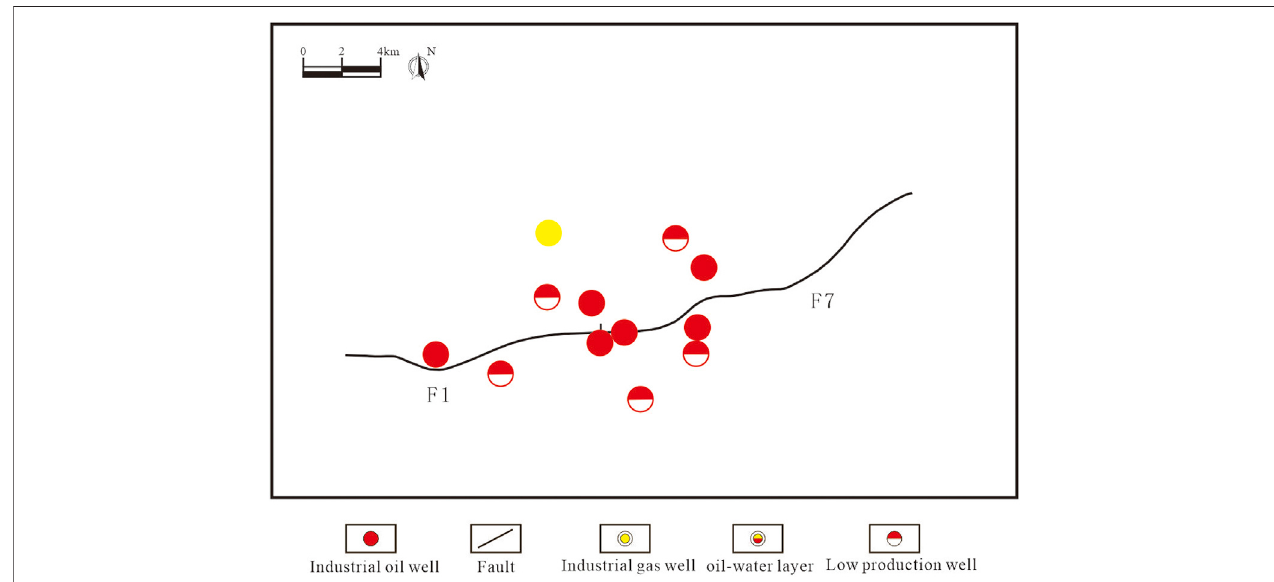
FIGURE 6 | Petroleum distribution relationship between the southwest of Jiuzhou fault and the middle and lower sub-member of Es3.